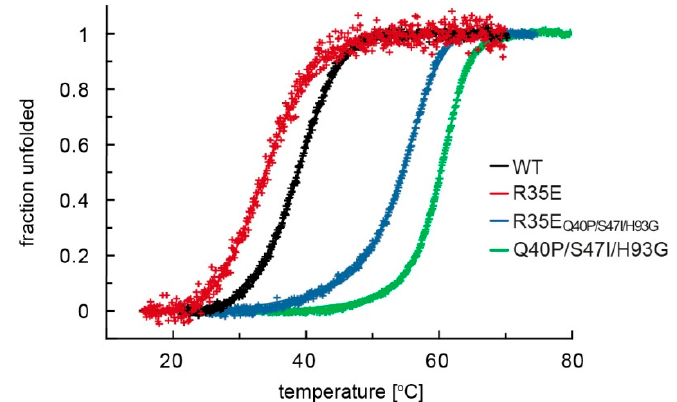
Figure 1. R35E mutation causes significant loss of stability of fibroblast growth factor 1 (FGF1). Normalized thermal denaturation curves of FGF1 variants monitored by the changes of ellipticity at 228 nm in the presence of 0.7 M guanidinium chloride. T den of FGF1 variants were calculated assuming two-state reversible thermal transition, and equal to 39.2 ◦ C for wild-type FGF1 ( ∆ H = 60.4 kcal / mol), 33.5 ◦ C for FGF1 R35E ( ∆ H = 46.4 kcal / mol) and 56.2 ◦ C for FGF1 R35E Q40P / S47I / H93G ( ∆ H = 87.7 kcal / mol) and 60.8 ◦ C for FGF1 Q40P / S47I / H93G ( ∆ H = 107.2 kcal /